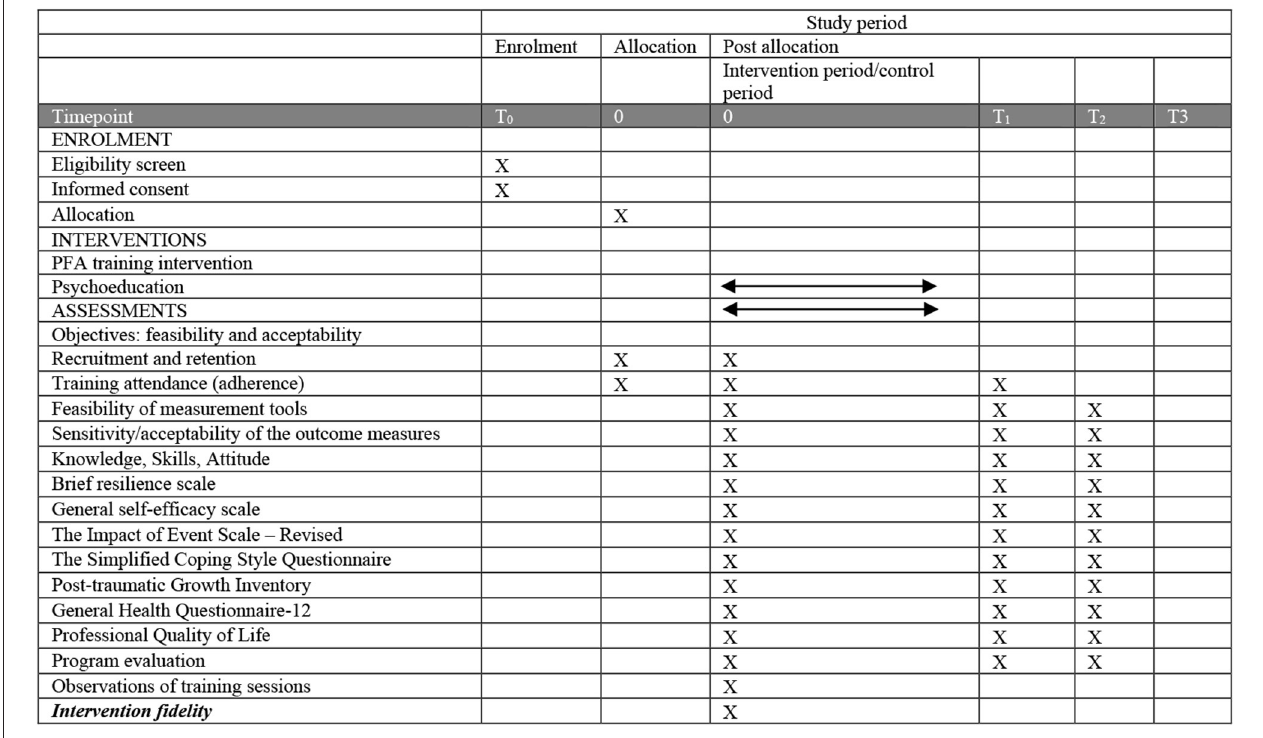
FIGURE 3 | Schedule of enrolment, interventions, and